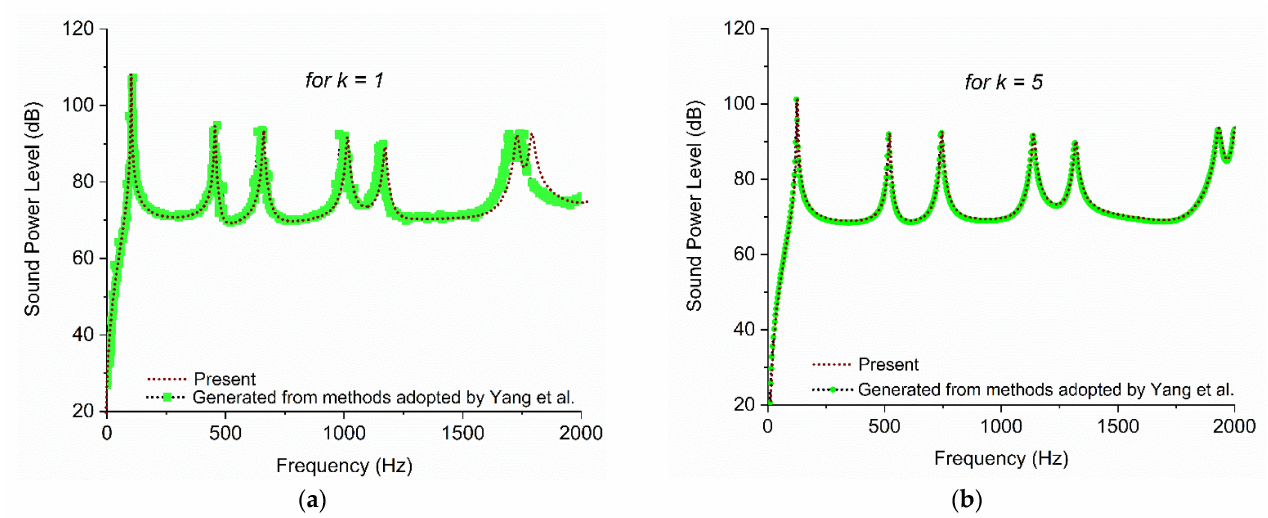
Figure 4. P-FGM plate’s SPL for k = ( a ) 1 and ( b ) 5, in comparison with Yang et al.